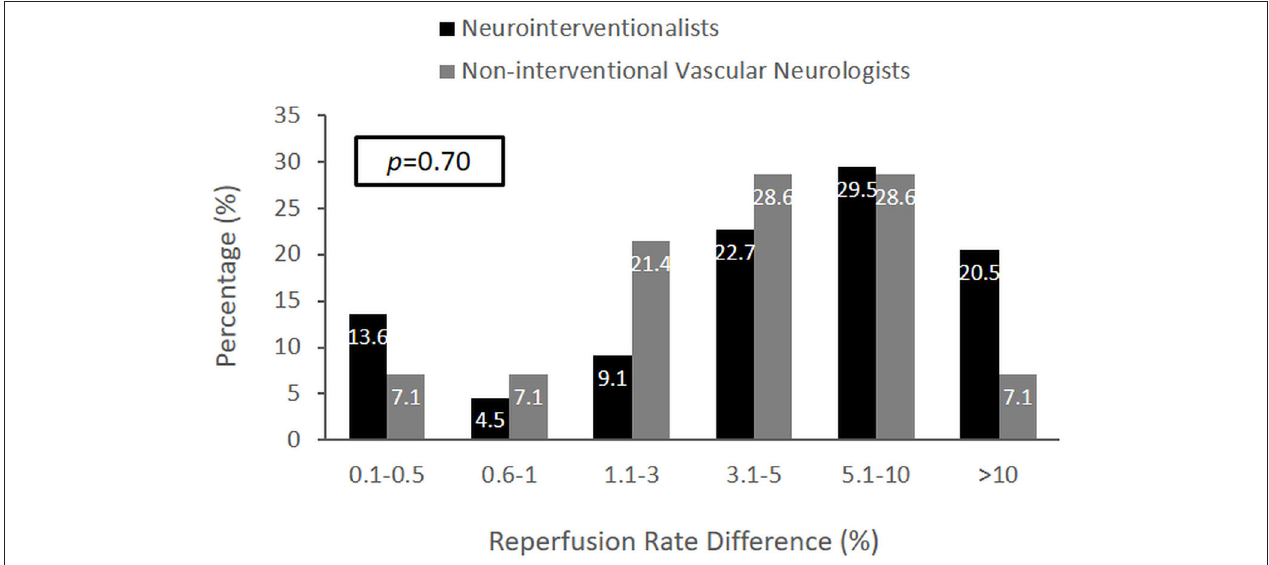
FIGURE 2 | The distribution of MCID responses comparing neuro-interventionalists and noninterventional vascular neurologists. The MCID distributions were not significantly different ( p = 0.70). However, the median MCID of vascular neurologists was within 3.1–5% (IQR 1.1–3% to 5.1–10%), and the median MCID of neuro-interventionalists was exactly 5% (IQR 1.1–3% to 5.1–10%).